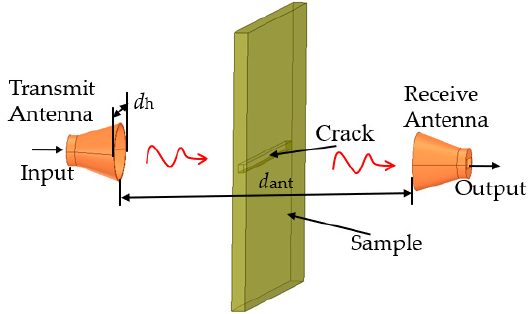
Figure 4. Detection system model built on CST MWS (not to scale).